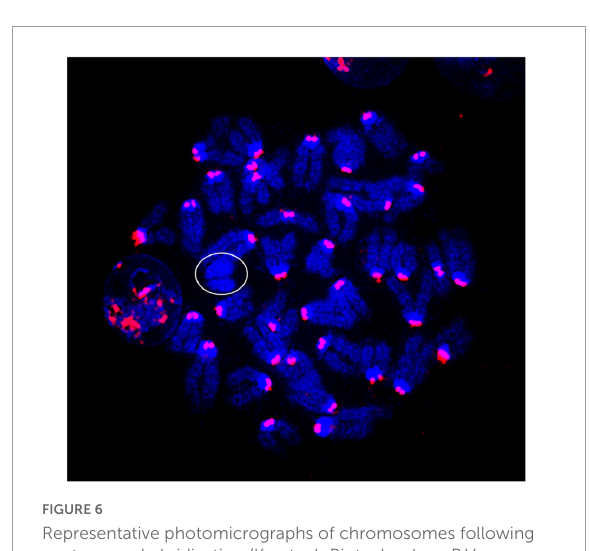
FIGURE6 Representative photomicrographs of chromosomes following centromere hybridization (Kreatech Biotechnology B.V, Amsterdam, Netherland). Each centromere shows 2 signals except Y-chromosome (circled) in both sham-irradiated and irradiated groups. The image was captured under 63x